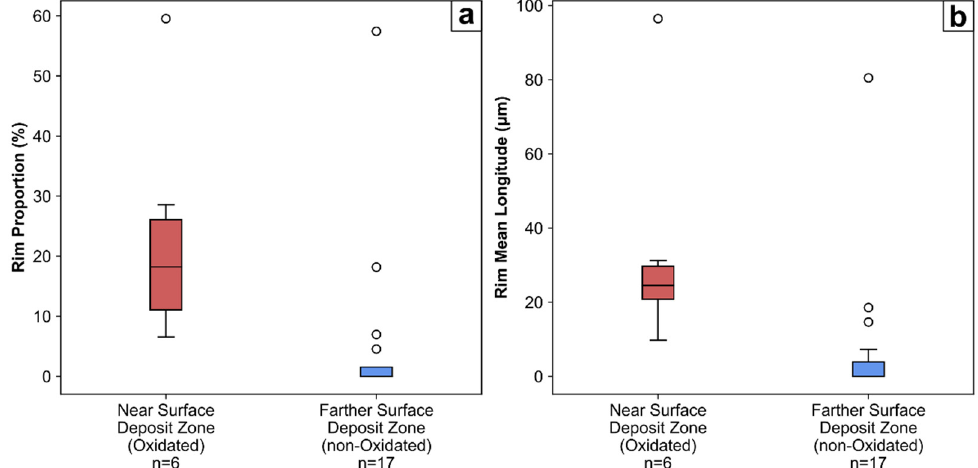
Figure 7. Differences in Ag-Hg depleted rim zonation size observed in different zones of the deposits. ( a ) Proportion of the particle cross-section affected by rim development. ( b ) Mean longitude of the rim. Near surface zones of the deposit (most oxidated), exhibit a higher rim development than the farther surface zones (non-oxidated).